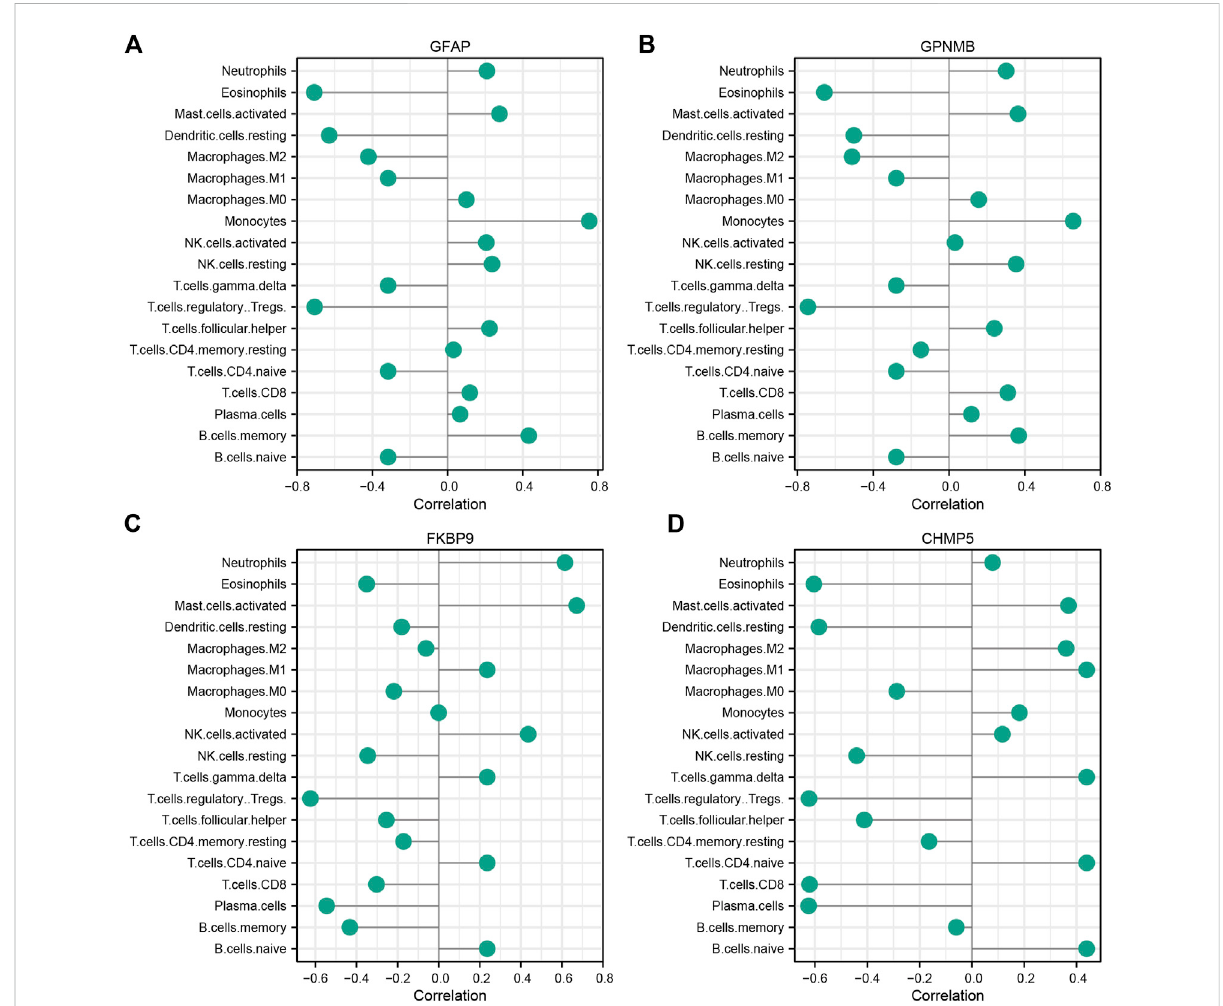
FIGURE 6 Correlation between characteristic ischemic stroke genes GFAP (A) , GPNMB (B) , FKBP9 (C) , and CHMP5 (D) and in fi ltrating immune